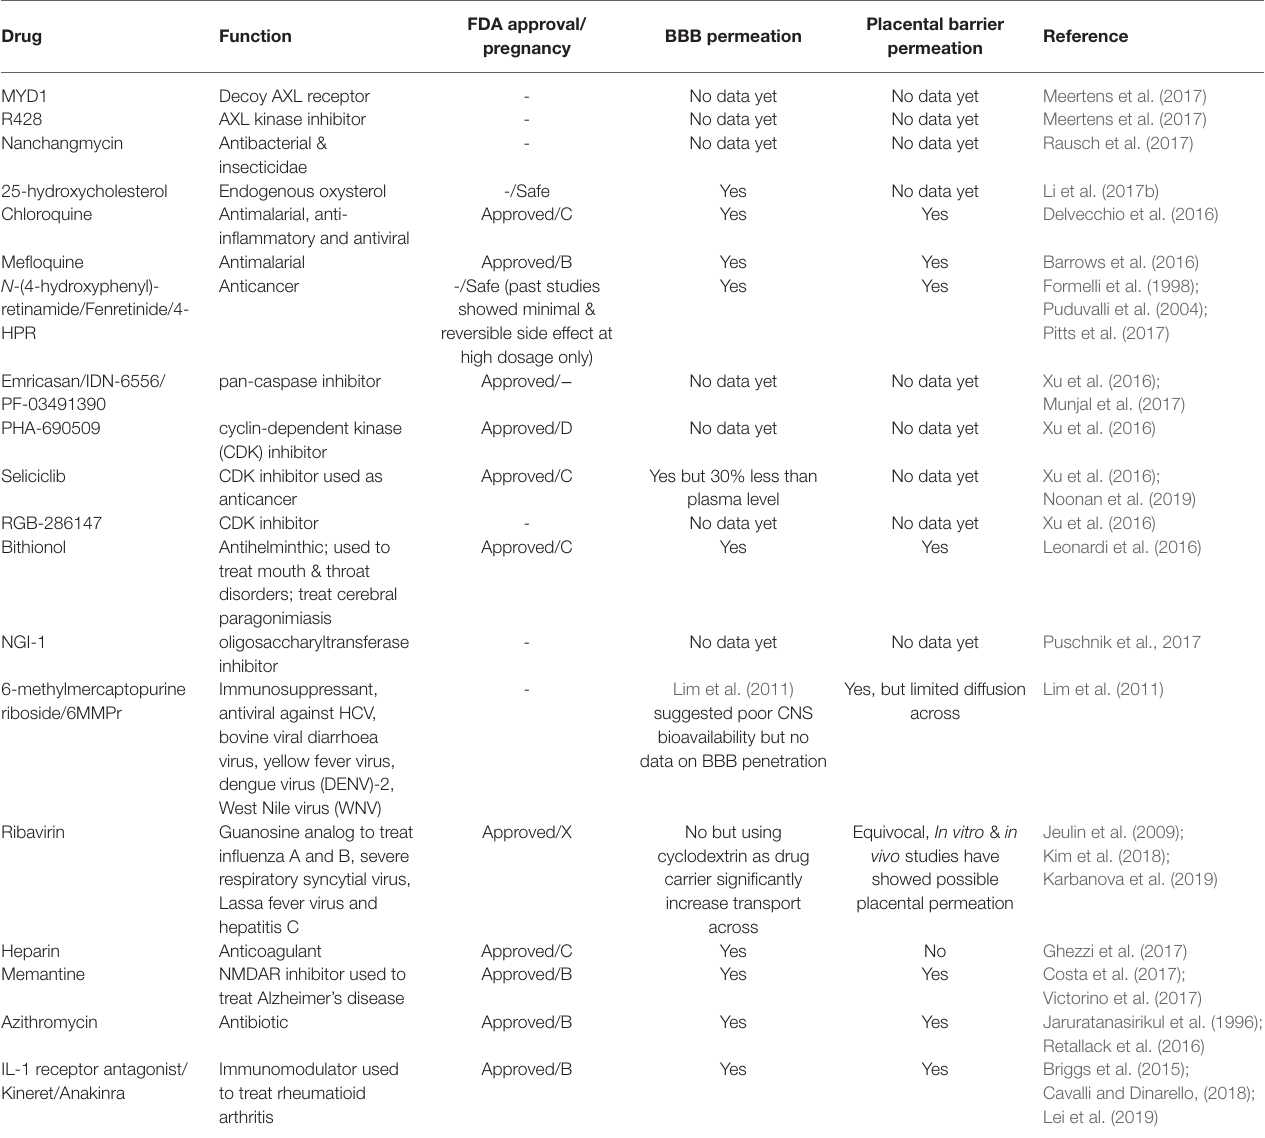
TABLE 2 | Potential anti-ZIKV drugs focusing on studies done on neuronal cells.